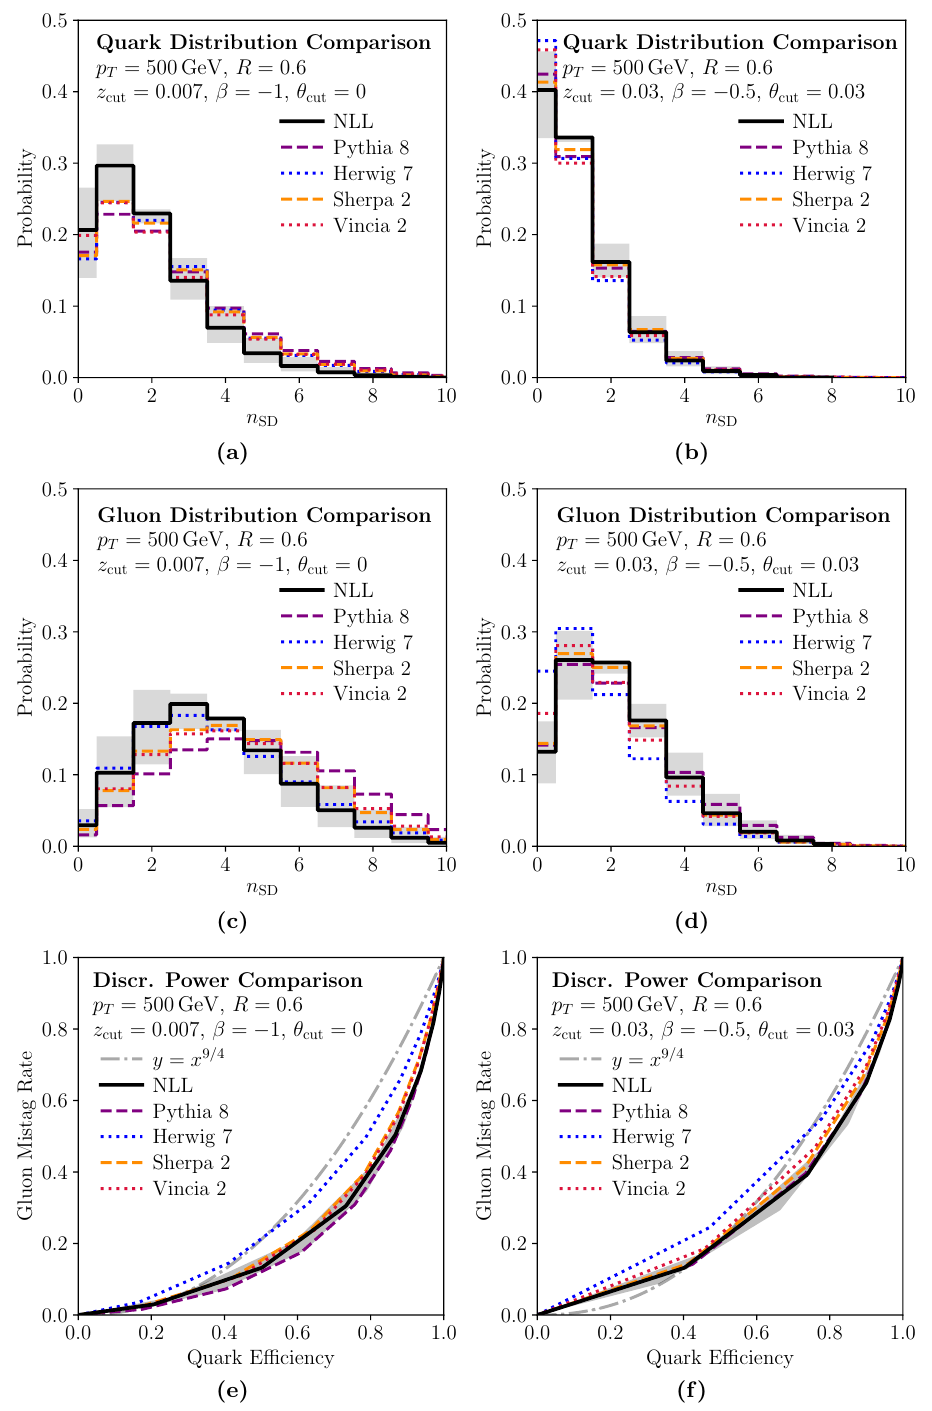
Figure 14. Analytic NLL distributions compared to parton shower generators for (top row) quark jets, (middle row) gluon jets, along with (bottom row) the corresponding ROC curves. Parameters are chosen according to eqs. (3.17), (3.18) and (3.20) with (cid:3) NP = 2 GeV and (left column) (cid:12) = and (right column) (cid:12) = 0 : 5. (cid:0)